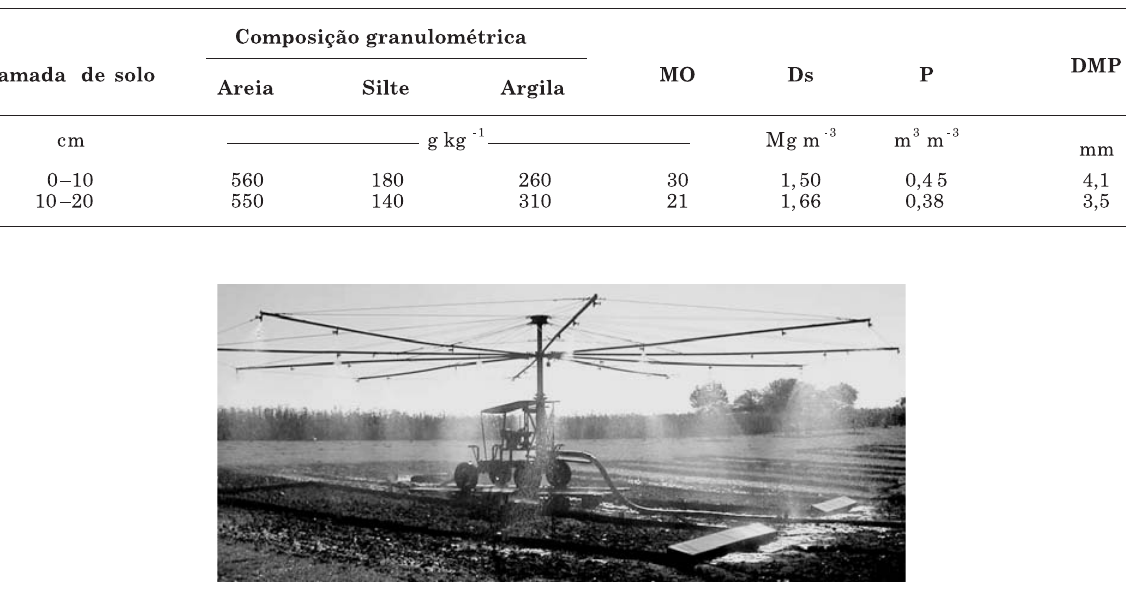
Figura 1. Aparelho simulador de chuva tipo de braços rotativos utilizado no estudo, simultaneamente ope- rando sobre um par de parcelas experimentais de